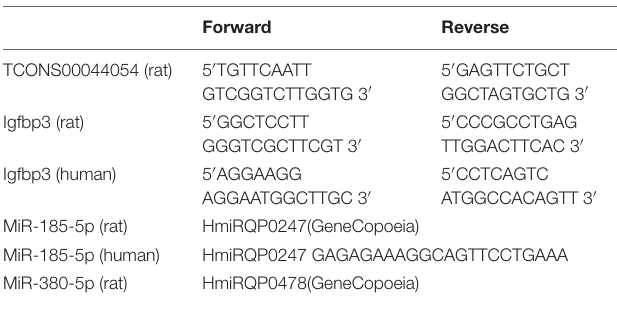
TABLE 1 | The primer